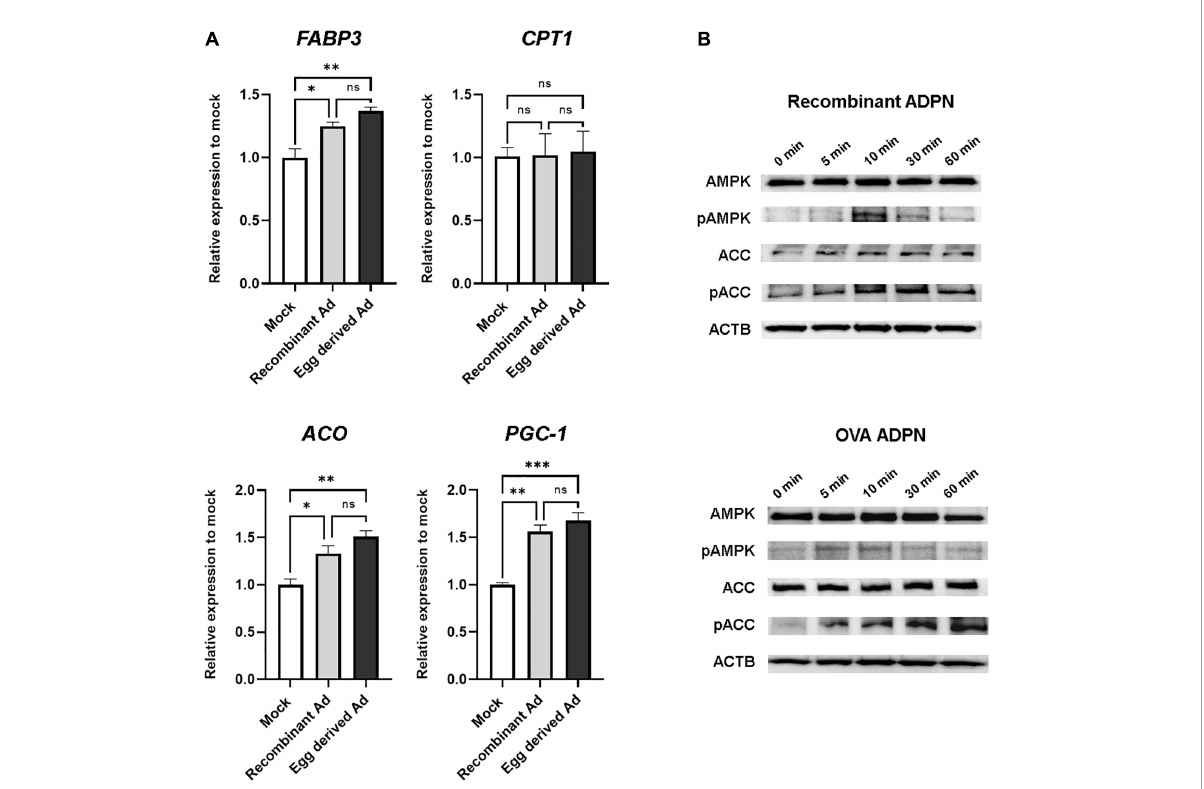
FIGURE5 Egg-derived ADPN stimulates PPAR α target genes and AMPK signaling pathway. (A) The relative mRNA expression levels of PPAR α target genes (including FABP3 , CPT1 , ACO , and PGC-1 ) after 3 h treatment of 2 µ g/ml adiponectin on C2C12 myoblast cell line. The amount of mRNA was normalized to GAPDH . To determine if any significant differences existed between mock control group, recombinant Ad group, and egg derived Ad group in PPAR α target gene expression are validated One-way Anova [Tukeys’ multiple comparison tests ( n = 3)]. Mock, PBS treatment group; Ad, adiponectin. (B) Activation of AMPK pathway by 5 µ g/ml of adiponectin treatment. Time-dependent activation of AMPK and ACC by adiponectin. Recombinant Ad (ADPN), commercially available recombinant human adiponectin; Egg-derived Ad (ADPN), purified adiponectin from OVA ADPN KI chicken egg. ACTB (Beta–actin) was used as a loading control. Significant differences between groups are indicated as ∗ P < 0.05, ∗∗ P < 0.01, and ∗∗∗ P <